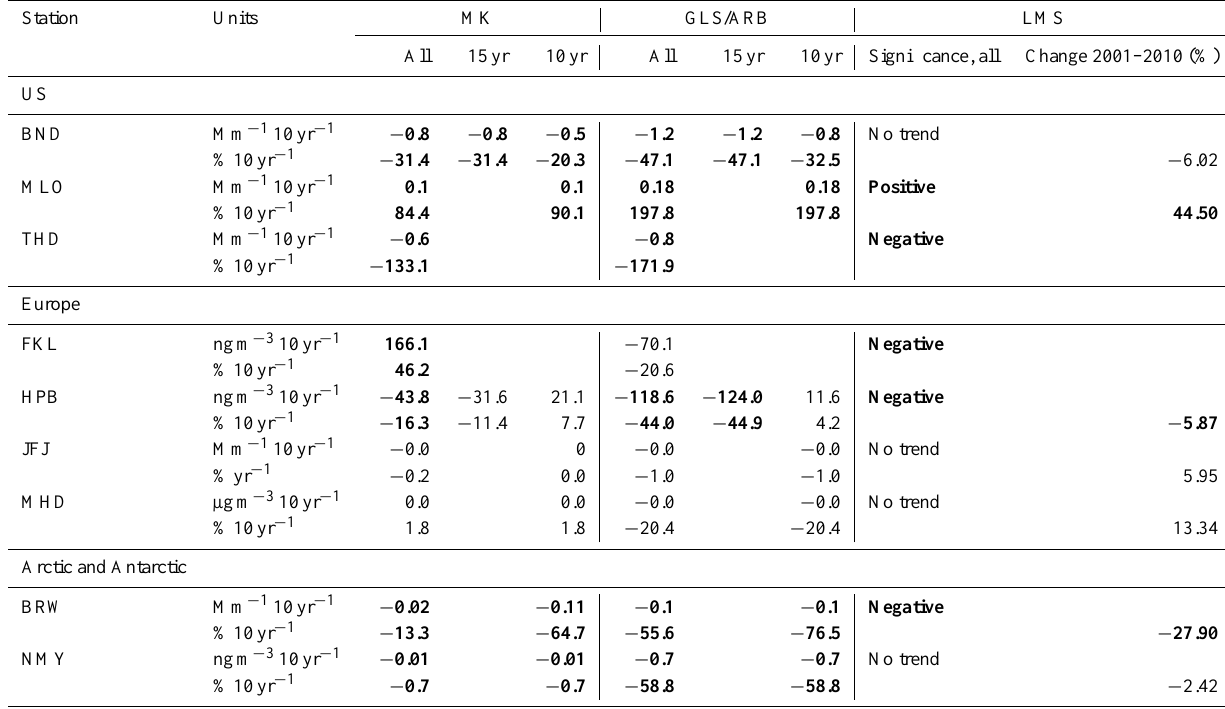
Table 5. Significance and slope of the trends of the absorption coefficient; the color scheme and labels are similar to Table 3. Station Units MK GLS/ARB LMS All 15yr 10yr All 15yr 10yr Significance, all Change 2001–2010 (%) US BND